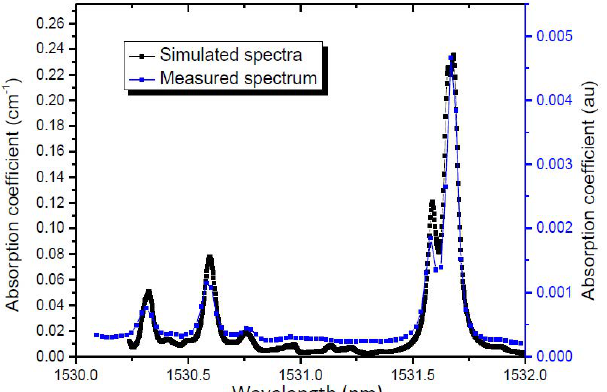
Figure 5. Simulation of the absorption spectra of pure NH 3 using the HITRAN database (black line) and measured absorption spectrum (blue line). The pressure is set to 1 atm and the temperature to 296 K.